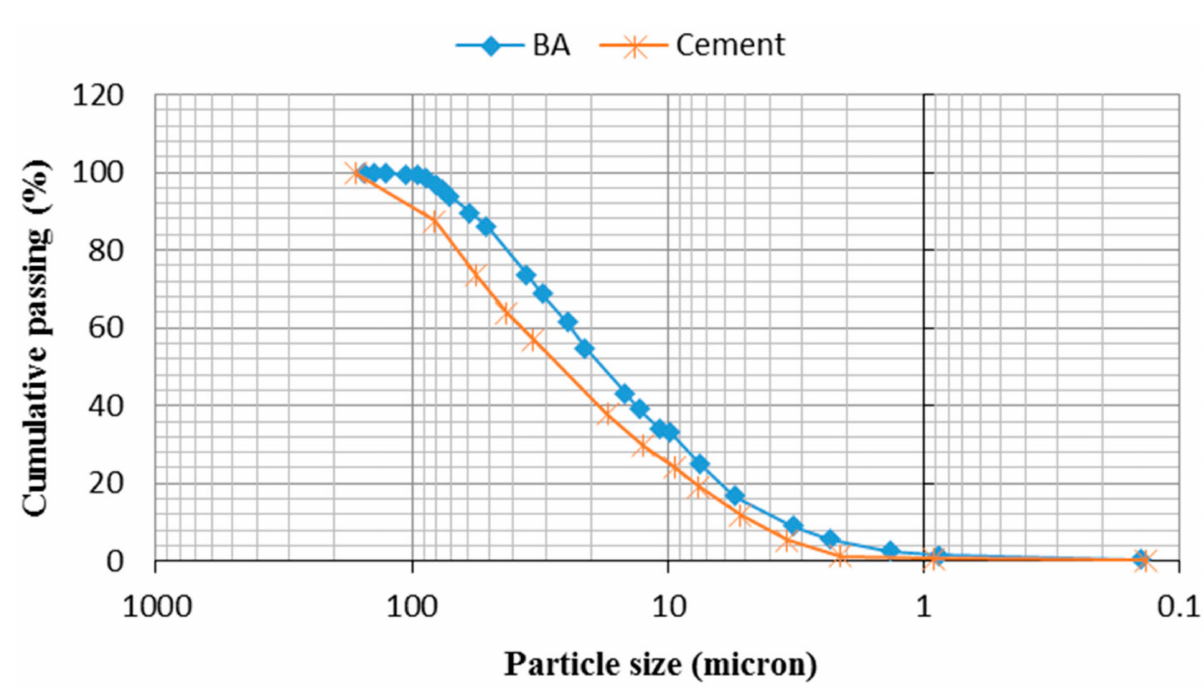
Figure 6. Particle size distribution of ground BA and